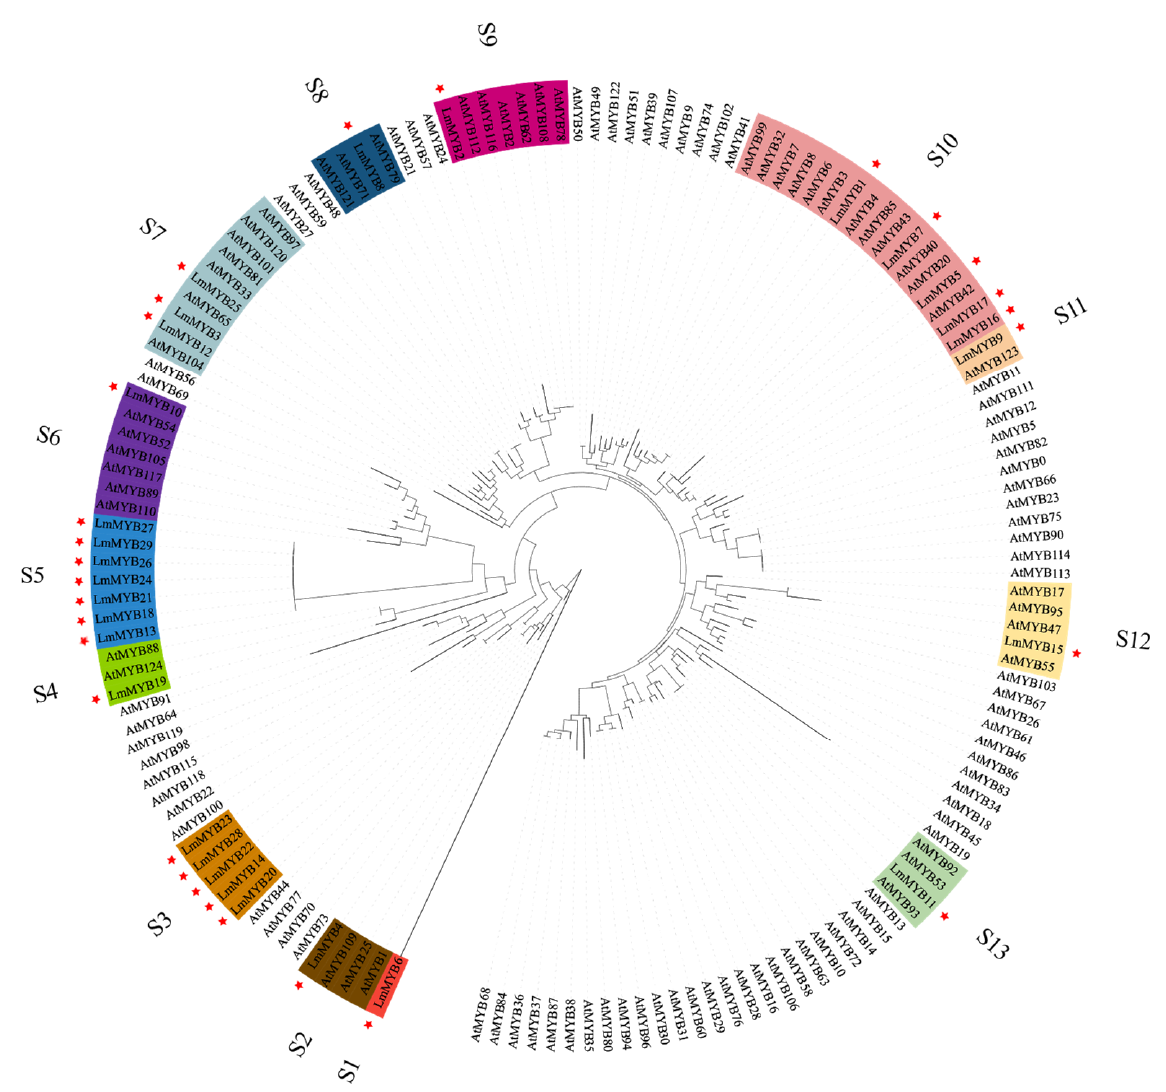
Figure 5. Phylogeny and distribution of R2R3-MYB transcription factors. The phylogenetic tree of R2R3-MYB proteins shows family members from both Arabidopsis thaliana and Lolium multiflorum . The tree was generated with MEGA 7.0 software using the neighbor-joining (NJ) method based on the inferred amino acid sequences. R2R3-MYB members in L. multiflorum are labeled with red stars. S1 to S13 represent each of the different subgroups.